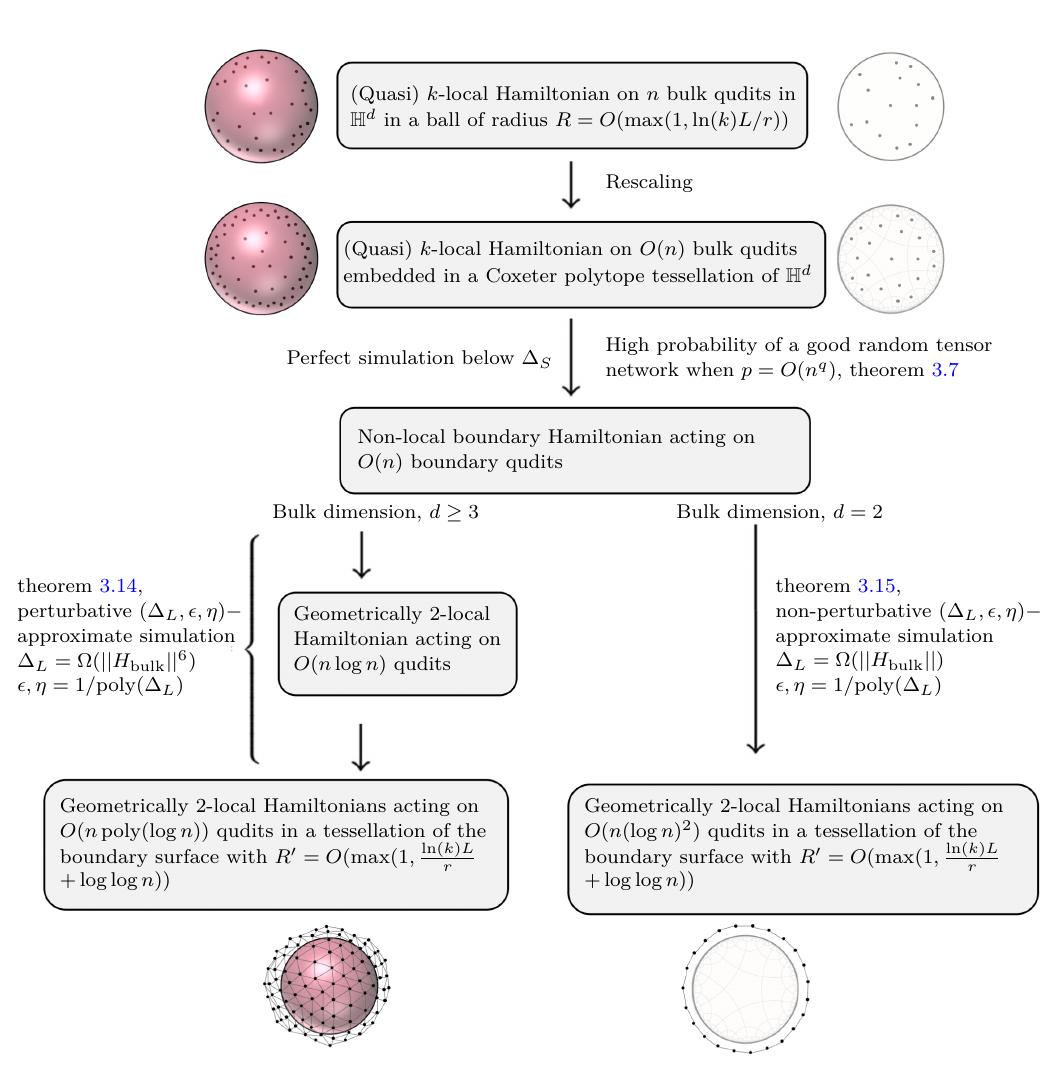
Figure 4 . Sequence of simulations used to create holographic toy models. Full details can be